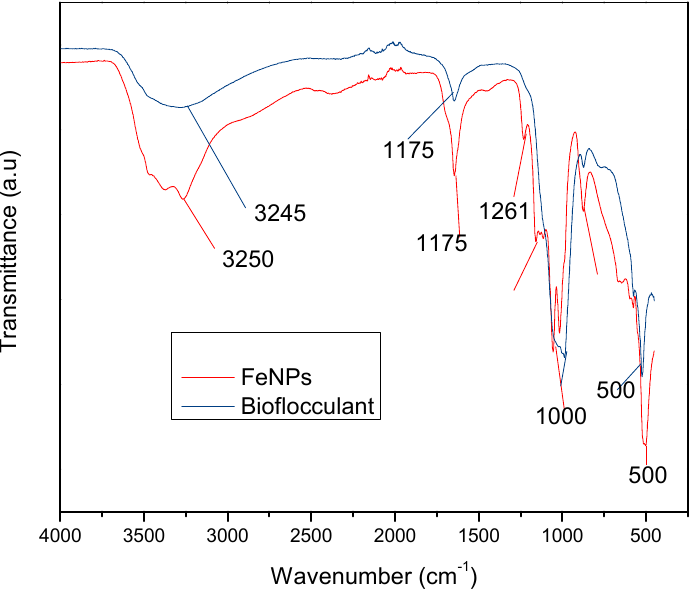
Figure 1. Fourier transform-infrared (FT-IR) spectra of the bioflocculant and iron nanoparticles.